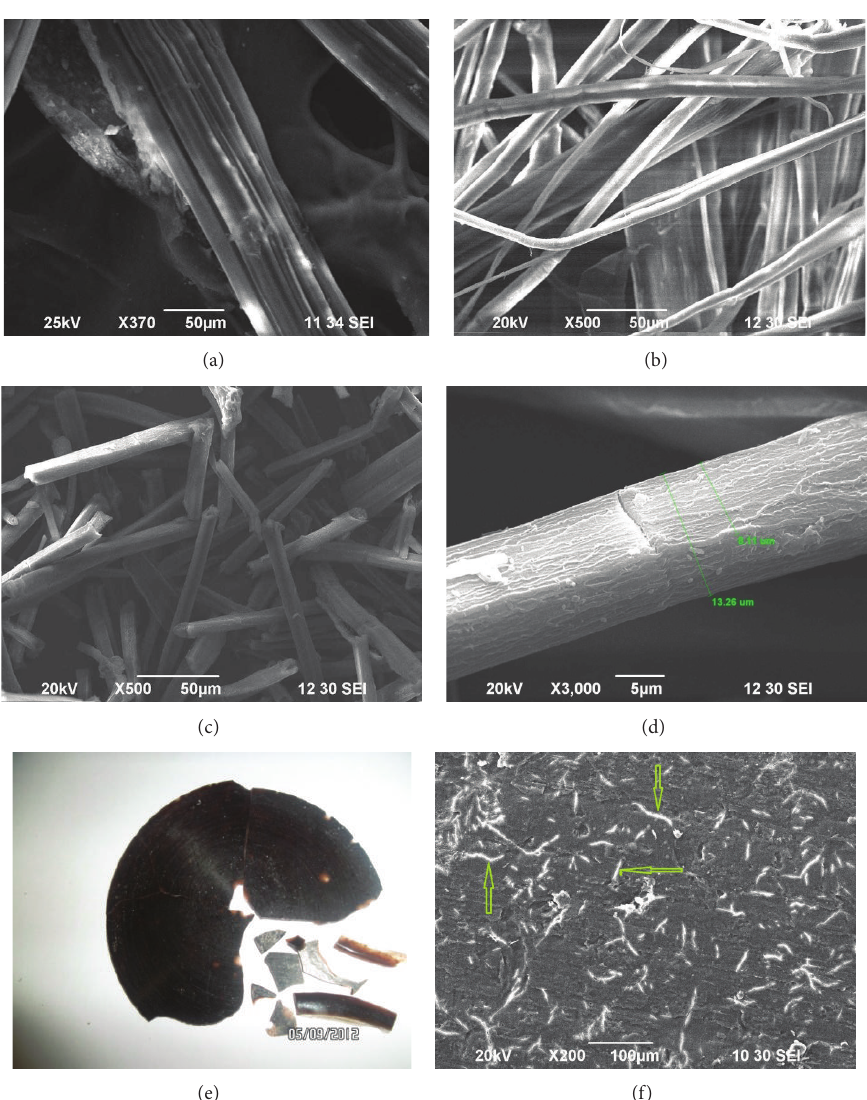
Figure 1: SEM images of CCs and biocomposite. (a) Mercerized jute, (b) bleached jute, (c) and (d) acid hydrolyzed jute, (e) picture of composite, and (f) image of PLA/CC biocomposite with 15%